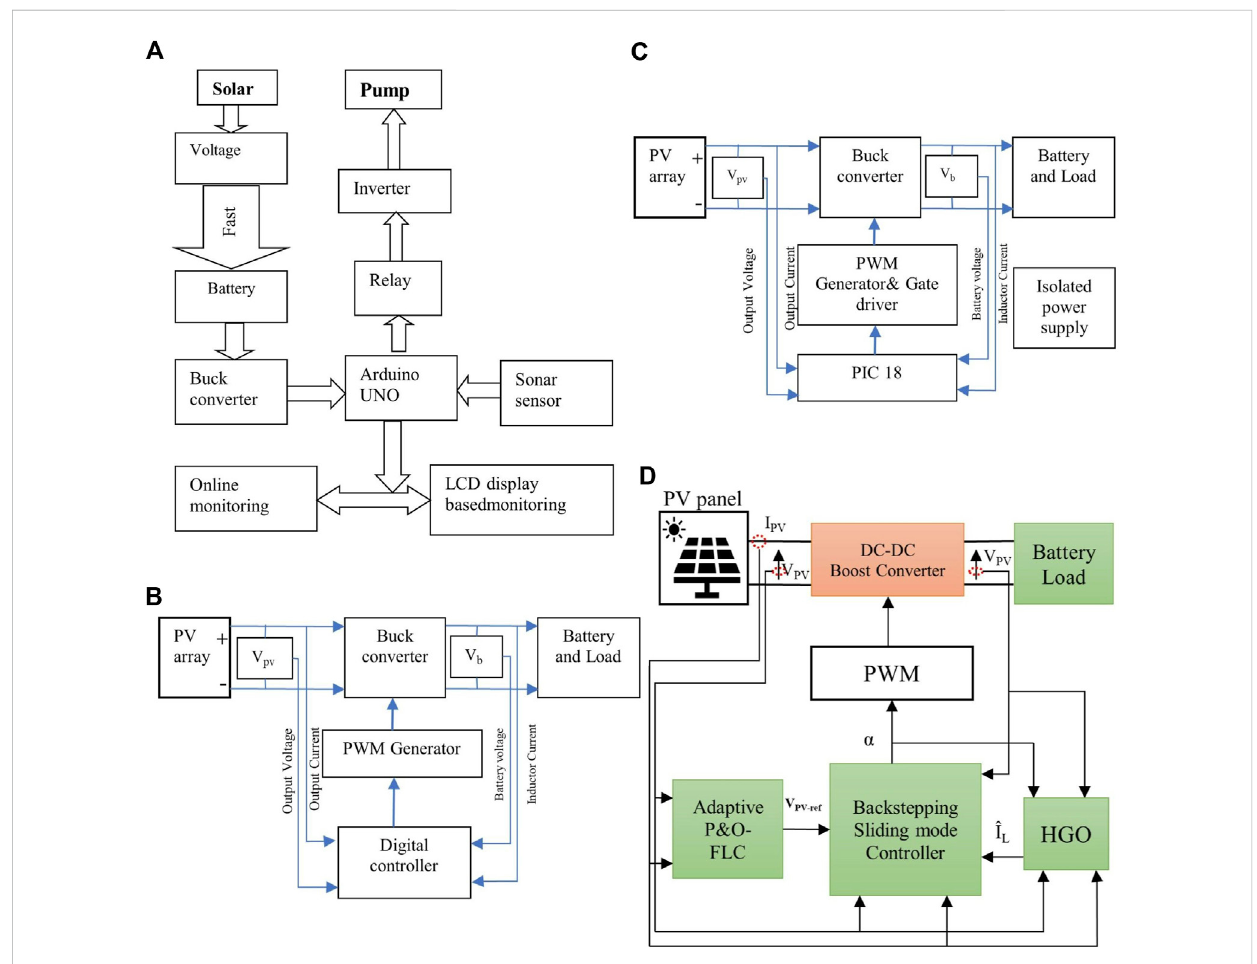
FIGURE 9 A PV-Battery charging system as (A) introduced within a smart irrigation system to improve production ef fi ciency (Shu fi an et al., 2021). (B) based on PI controller (Chtita et al., 2021). (C) Implemented by a DC-DC boost converter in a PWM signal (Sansare et al., 2018). (D) MPPT-based boost converter with a combination of the adaptive P&O fuzzy logic controller MPPT and (BS-SMC) technique (Sansare et al.,